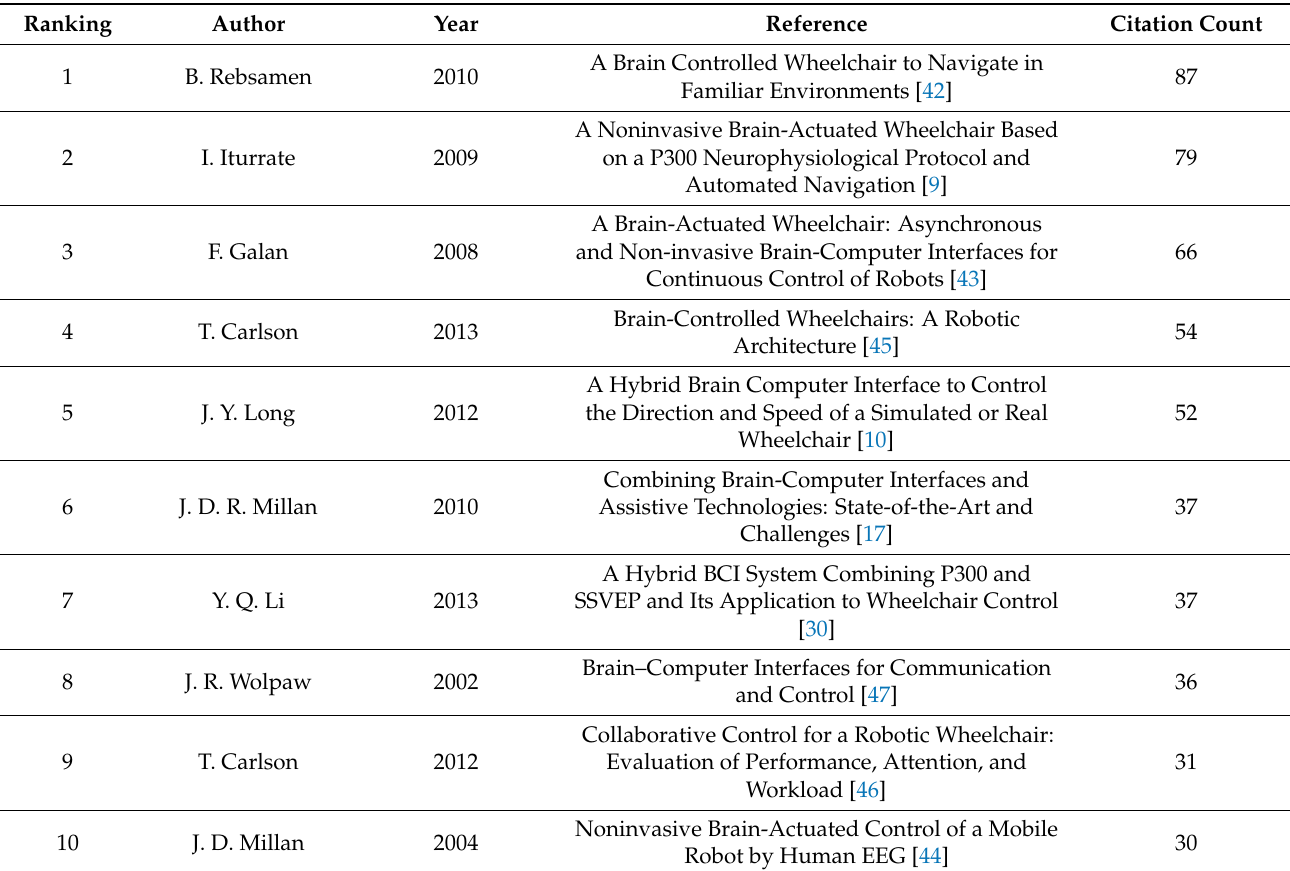
Table 7. Top 10 most cited references in EPW HMI methodology